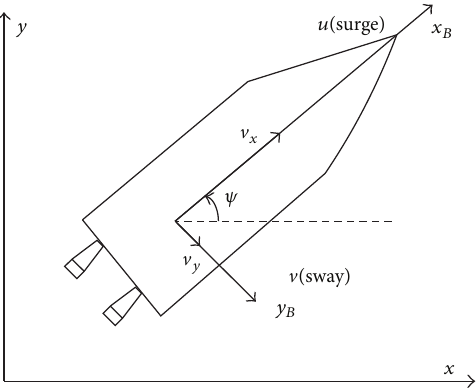
Figure 1: Underactuated surface